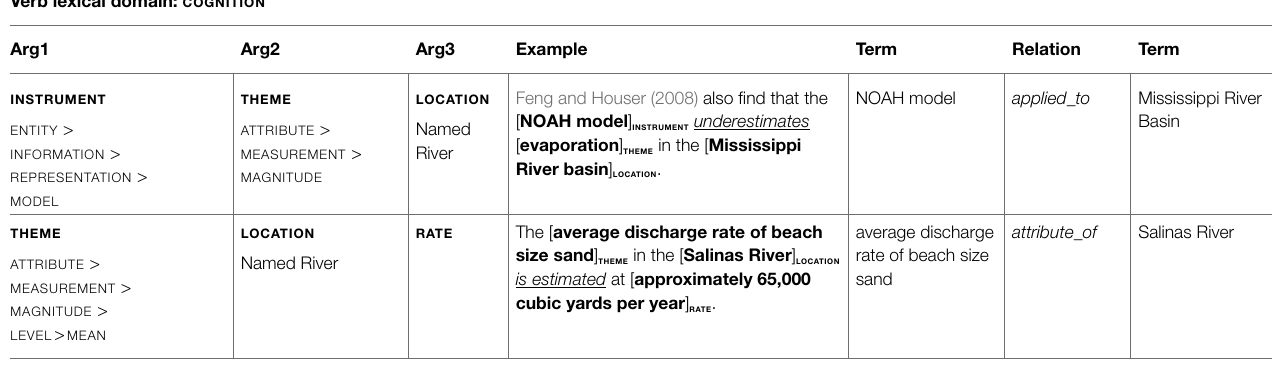
TABLE 11 | Results from the semantic annotations for the lexical domain of cognition . Verb lexical domain: